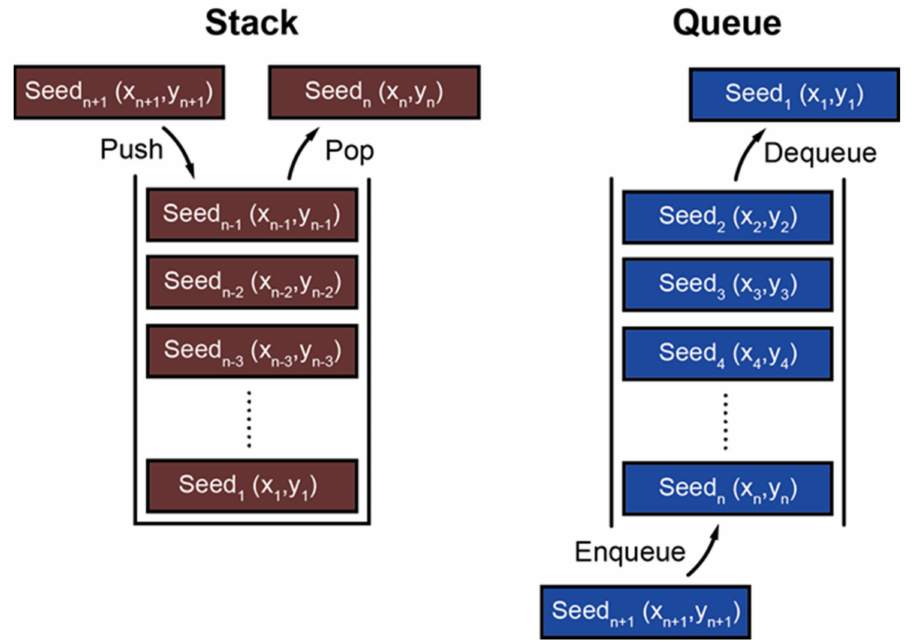
Figure 4. Representation of a Last-In-First-Out (LIFO) stack ( left ) and a First-In-First-Out (FIFO) queue ( right